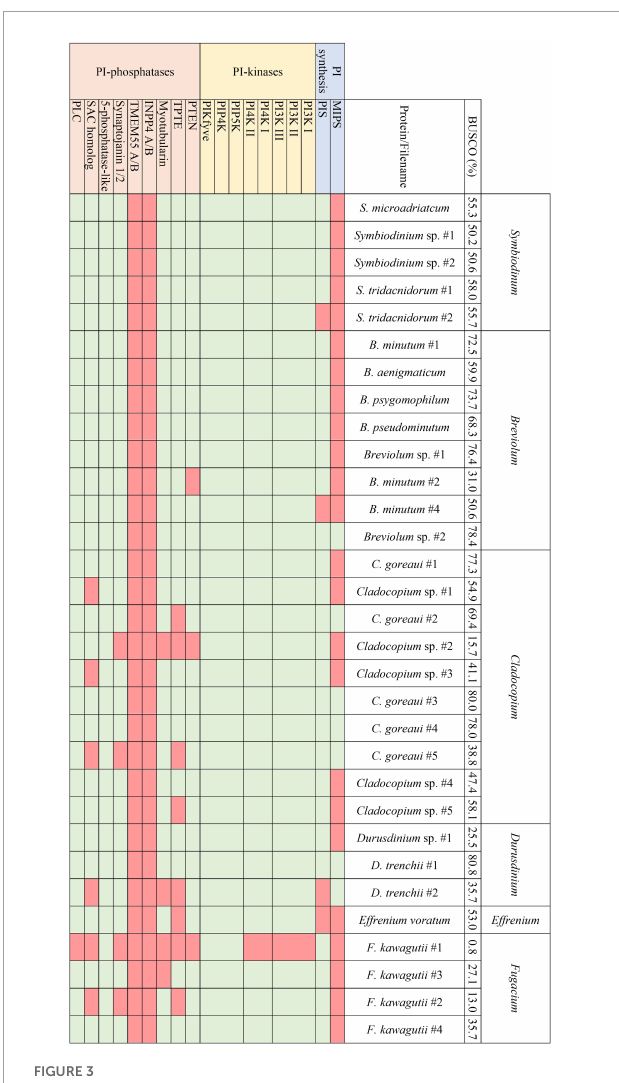
FIGURE3 The presence and absence of the proteins constituting the PI pathway across all available Symbiodiniaceae assemblies and the respective BUSCO scores.